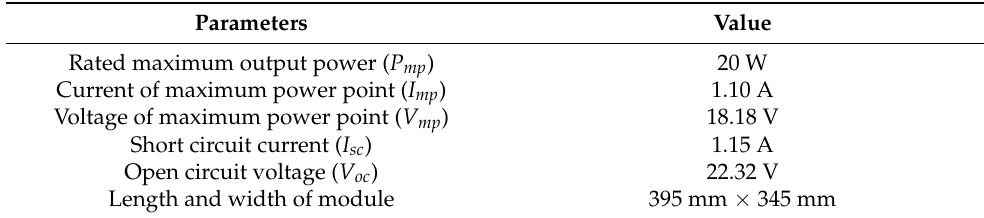
Table 1. Specifications of electrical parameters of photovoltaic modules SWM-20W produced by Sunworld